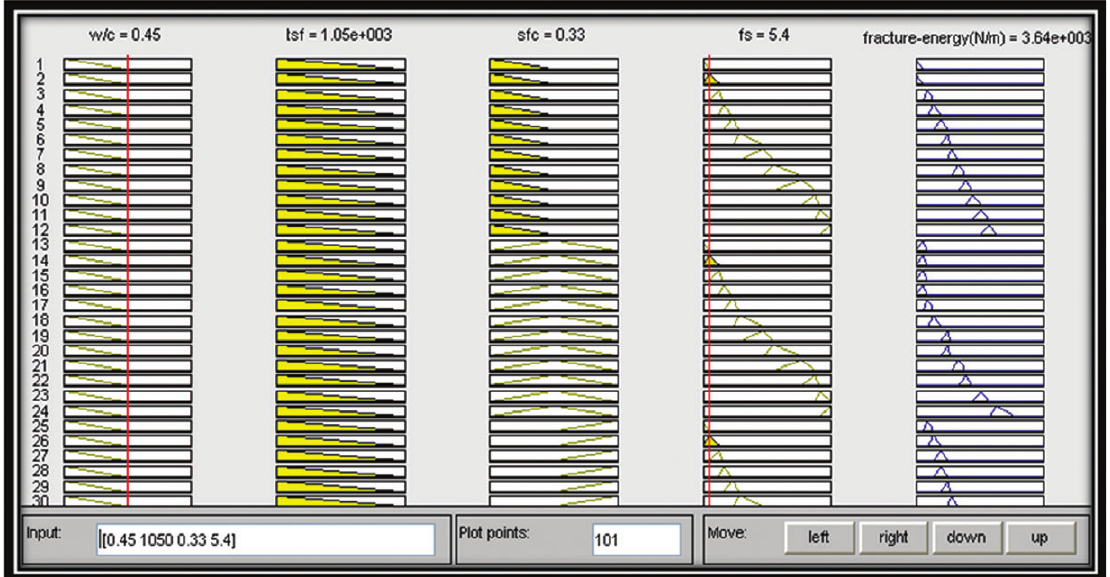
Figure 5 Defuzzification monitor of the